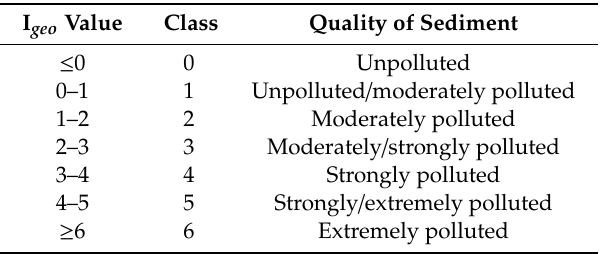
Table 1. Müller’s classes for the geoaccumulation